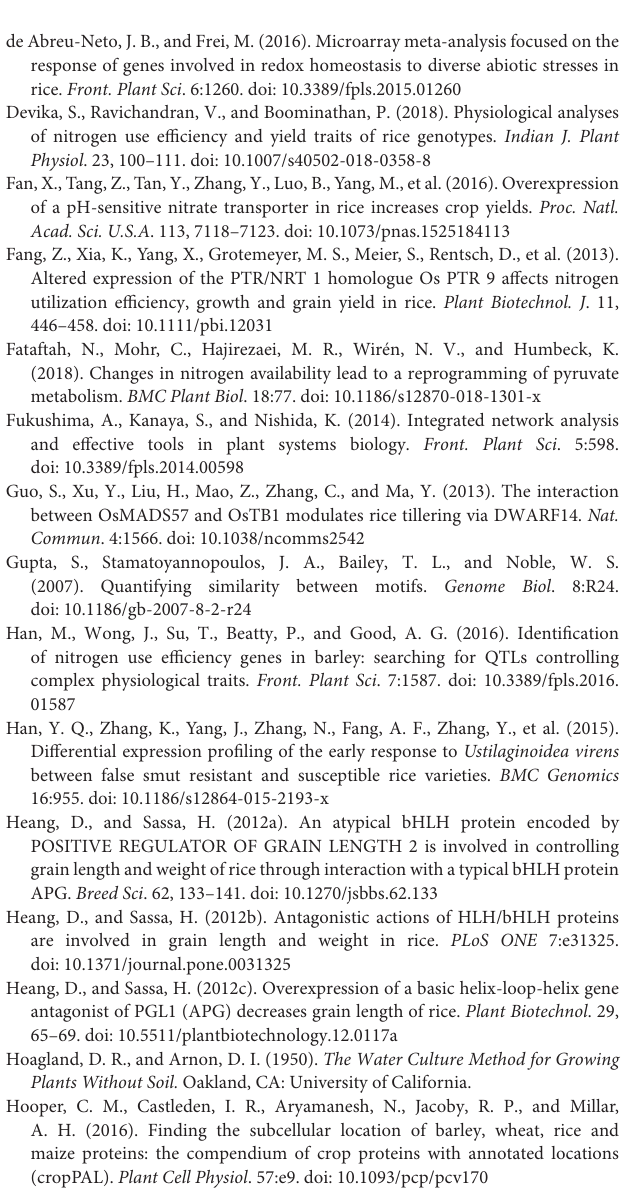
Supplementary Table S12 | Major transporters encoded by 85 NUE genes, and their families, functions, and references. Supplementary Table S13 | NUE-related 44 unique microRNAs (miRNAs) and their target genes, traits, and references. Supplementary Table S14 | Details of different classes of kinases encoded by NUE-related genes and their classification and gene names based on i-TAQ database, the database by Vij et al. (2008), and Oryzabase database. Supplementary Table S15 | NUE-related gene-encoding phosphatases. Supplementary Table S16 | Cluster-wise pathway of protein among 1,064 NUE-related genes. Supplementary Table S17 | Major NUE quantitative trait loci (QTLs) (from the literature) regulating 18 unique traits onto which 327 NUE-related genes were co-localized.